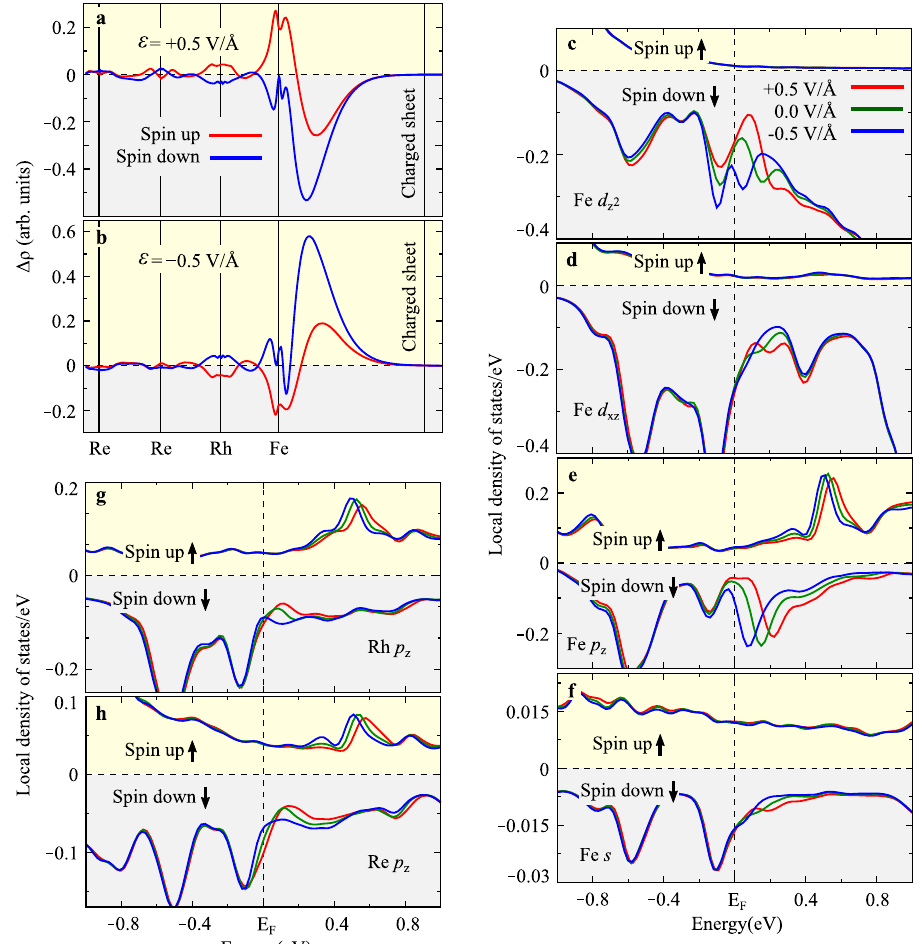
Fig. 2 Spin-dependent screening of electric fi elds at the surface. a , b Electric- fi eld induced spin-dependent charge density difference ð z ; EÞ = ρ ð z ; EÞ (cid:2) ρ ð z ; 0 Þ along the z -direction and averaged over the fi lm ( xy ) plane at E ¼ ±0.5 V/ Å . Solid red and blue lines denote Δ ρ σ σ σ ð z ; EÞ for spin-up ( σ = ↑ ) and spin-down ( σ = ↓ ) electrons, respectively. The position of the charged sheet, Fe, Rh, and fi rst two Re layers of Δ ρ σ Fe/Rh/Re(0001) fi lm are indicated. c – f Spin-polarized local density of states (LDOS) of Fe d z 2 , d xz , p z , s , Rh p z and Re p z orbitals, respectively. Each panel displays LDOS for electric fi elds of + 0.5 V/ Å (red), 0 V/ Å (green) and − 0.5 V/ Å (blue). The Fermi energy is indicated as E F